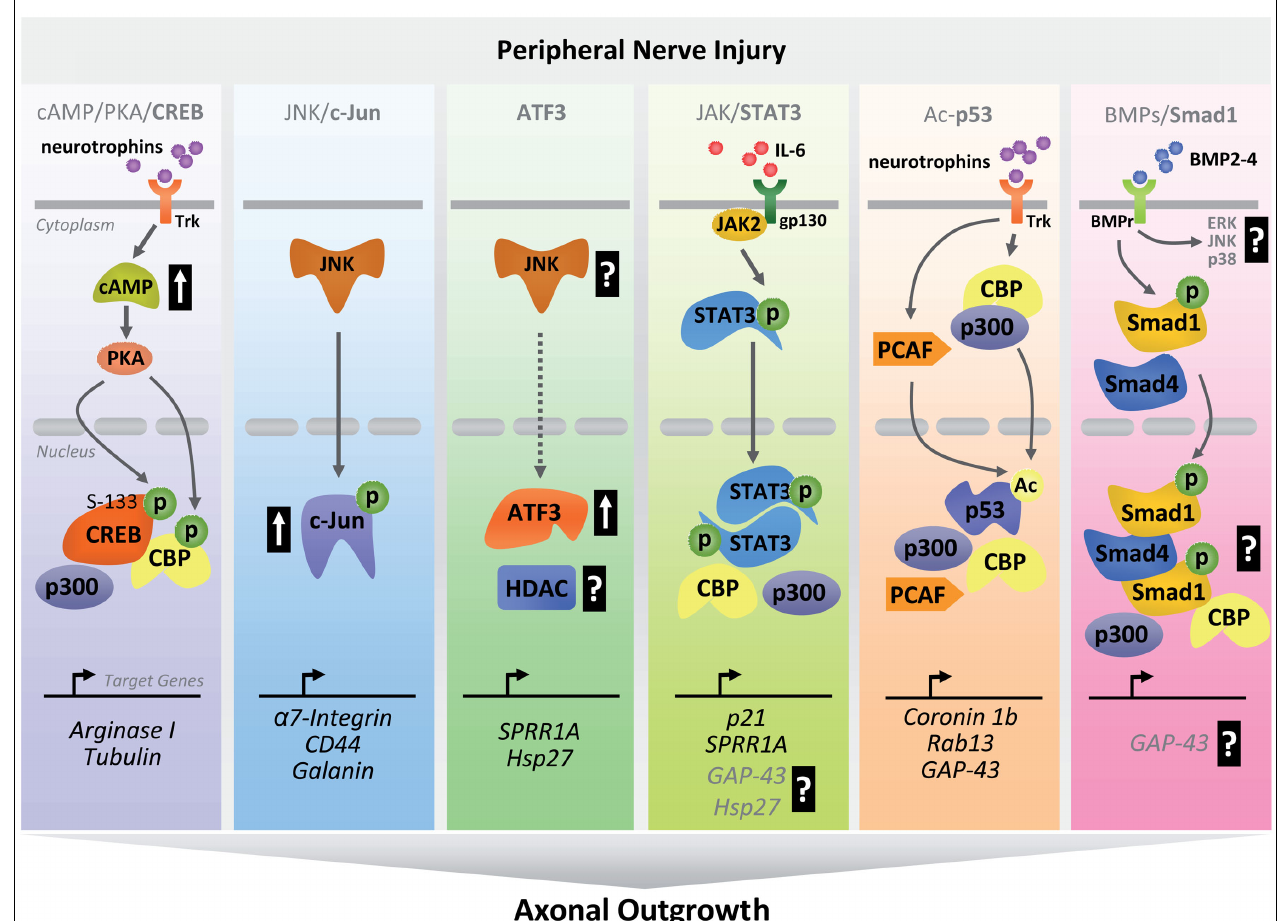
the nucleus where they bind to regulatory regions of regenerative-associated genes to drive their expression as part of an early pro-regenerative program (P, phosphorylation; Ac, acetylation; ERK, extracellular-signal-regulated kinase; p38, p38-mitogen-activated protein